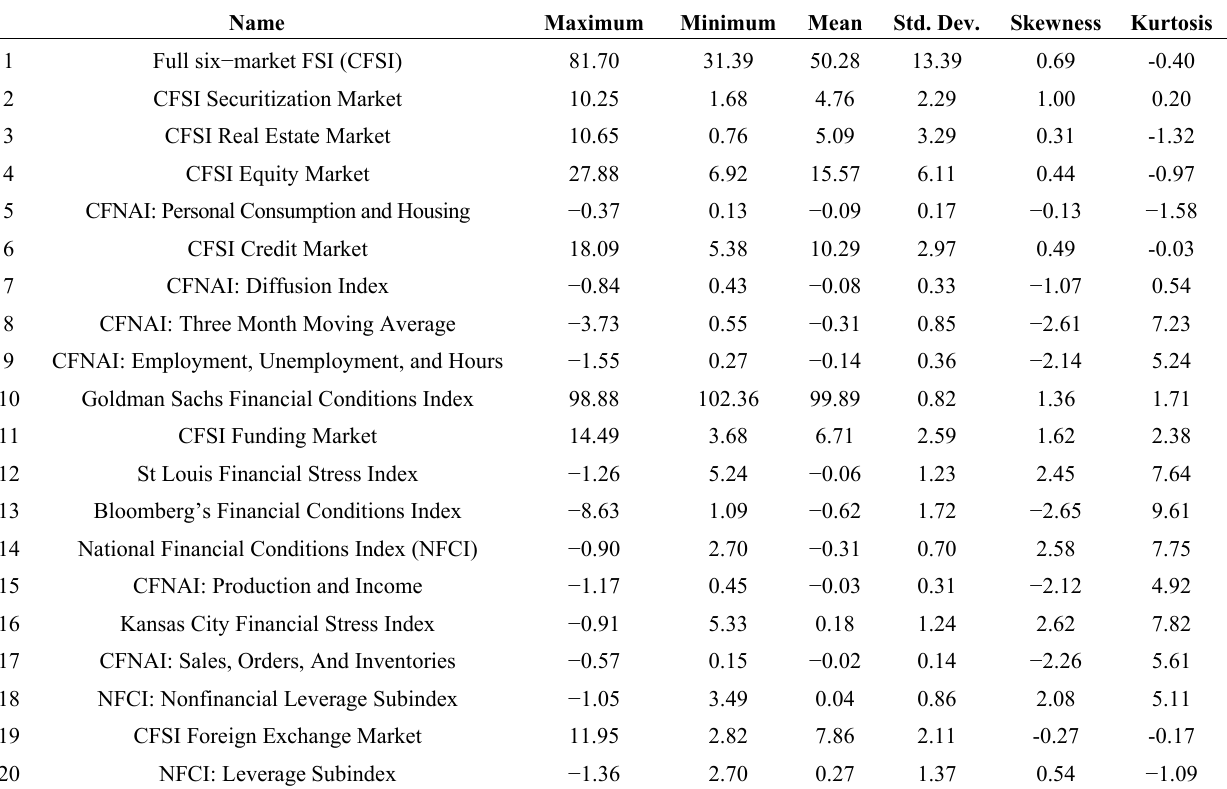
Table 4. Descriptive statistics for a collection of stress measures between 2002Q1 and